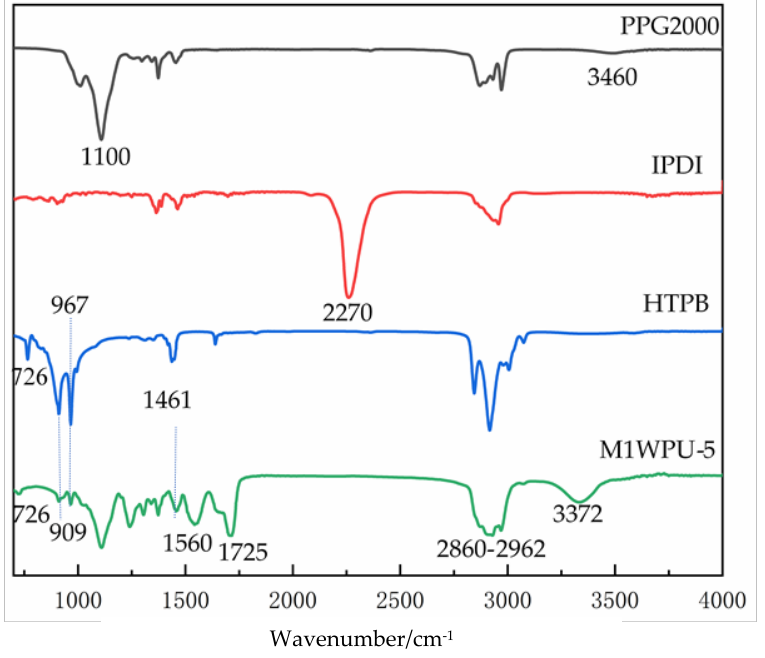
Figure 1. FTIR spectrum of PPG2000, HTPB, IPDI, and M1WPU5.